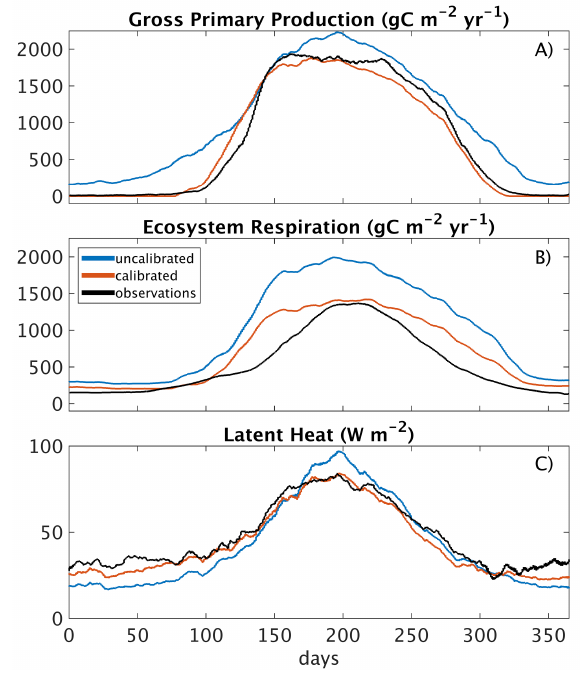
Figure 3. Seasonal averages (1999–2013) of simulated and ob- served land–atmosphere fluxes for (a) gross primary production (GPP), (b) ecosystem respiration (ER), and (c) latent heat (LE) for the limited nitrogen simulation. The observations are taken from the Ameriflux L2 processed eddy covariance flux tower data, partitioned into GPP and ER using the method of Reichstein et al. (2005). The uncalibrated simulation represents the CLM simula- tion without V cmax scaling and the calibrated simulation represents the CLM run using the V cmax scaling approach.